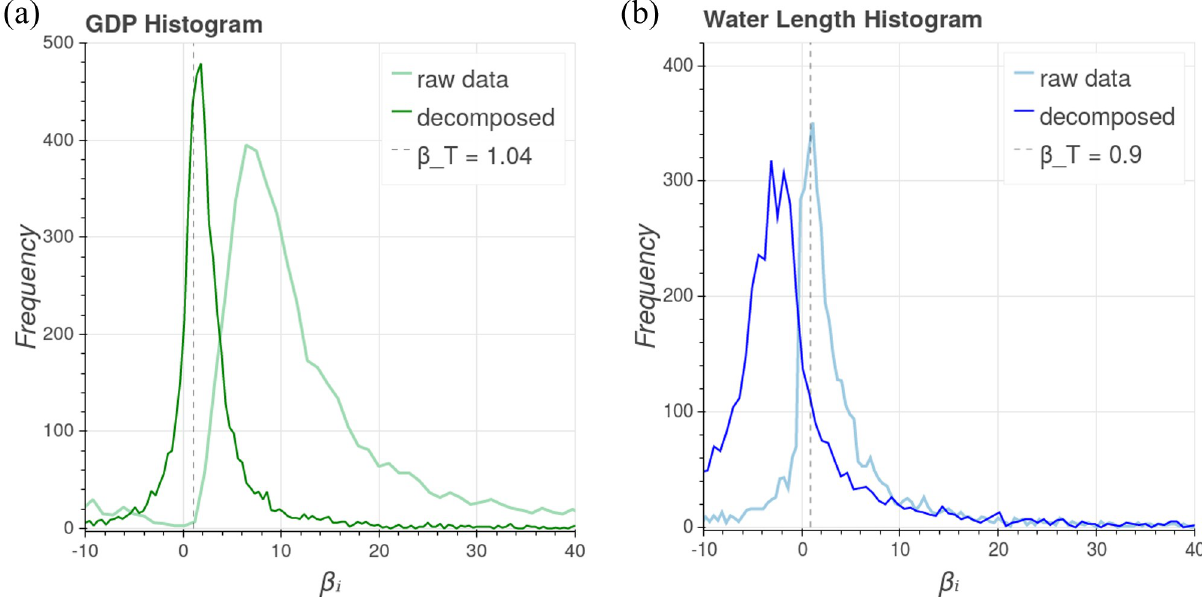
Fig 4. Histogram of the longitudinal scaling exponent sets { β the Brazilian cities. For GDP (on the left), the decomposed data is distributed around the transversal scaling exponent β suggesting that it makes sense to decompose this urban variable. However, in the case of water network length (on the right), the distribution of the raw (non-decomposed) data is closer to the global slope than the distribution of the decomposed one, suggesting that decomposition is not working for this urban